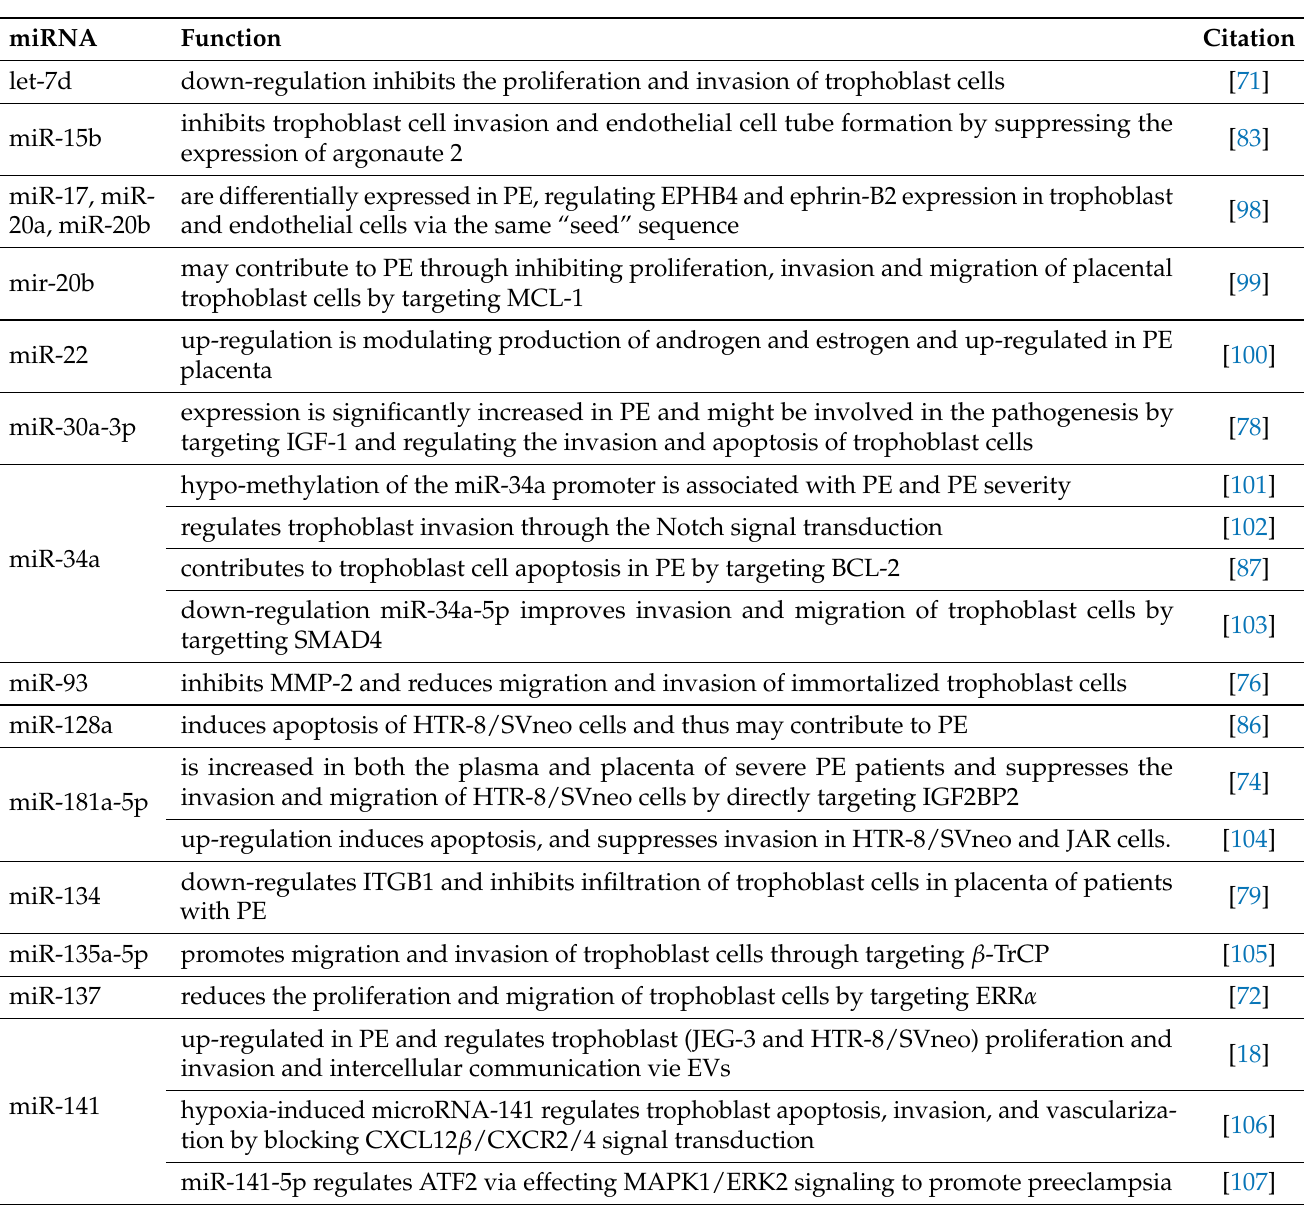
Table 2. MiRNAs and their role in preeclampsia (selection). For more details see the references and for a larger overview the reviews